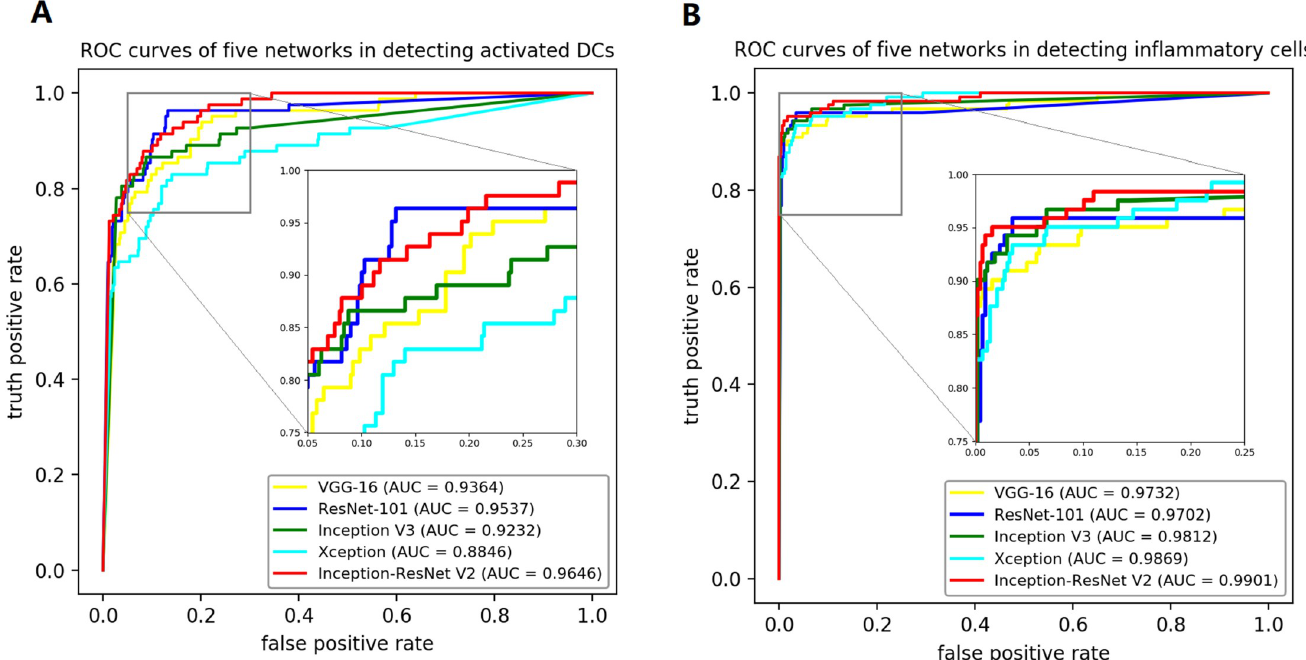
Fig 6. Performance of the deep transfer learning (DTL) models in external validation datasets. (A) shows the receiver operating characteristic (ROC) curves of five transfer models in identifying activated DCs. The area under the curve (AUC) ranged from 0.8846 to 0.9646. (B) shows the ROC curves of five transfer models in identifying inflammatory cells. The AUC ranged from 0.9701 to